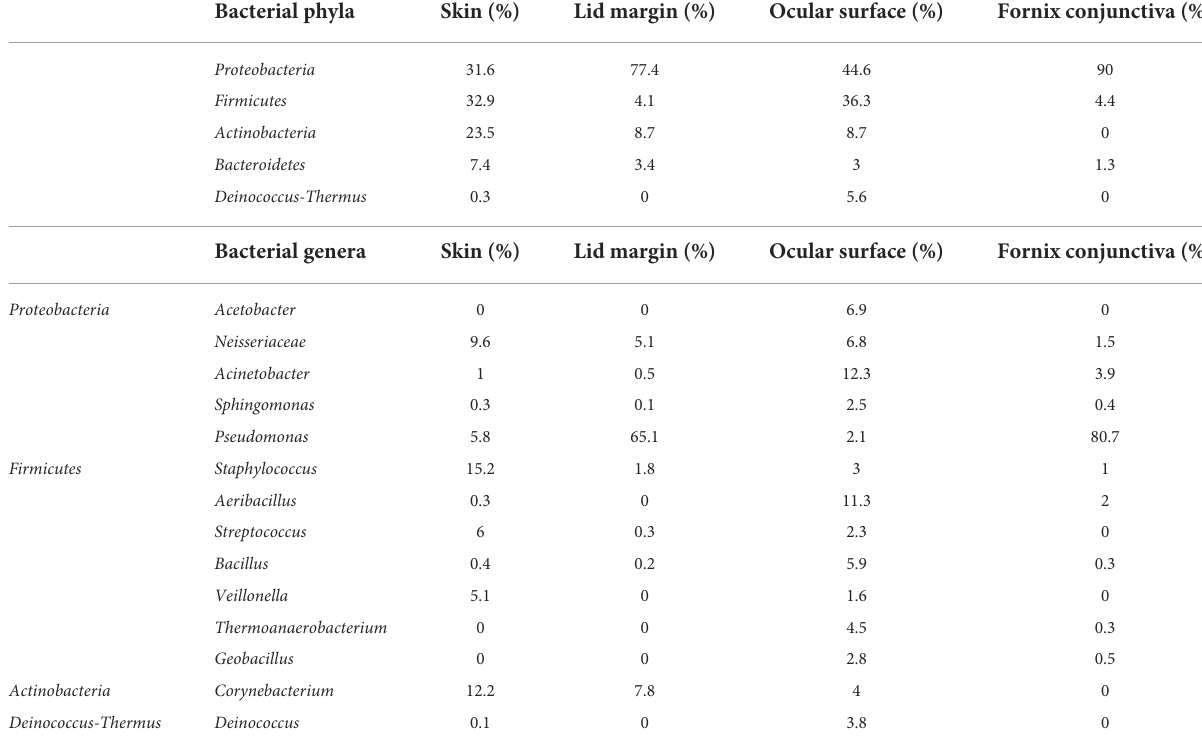
TABLE 1 Members of OSM on ocular surface by Ozkan et al.